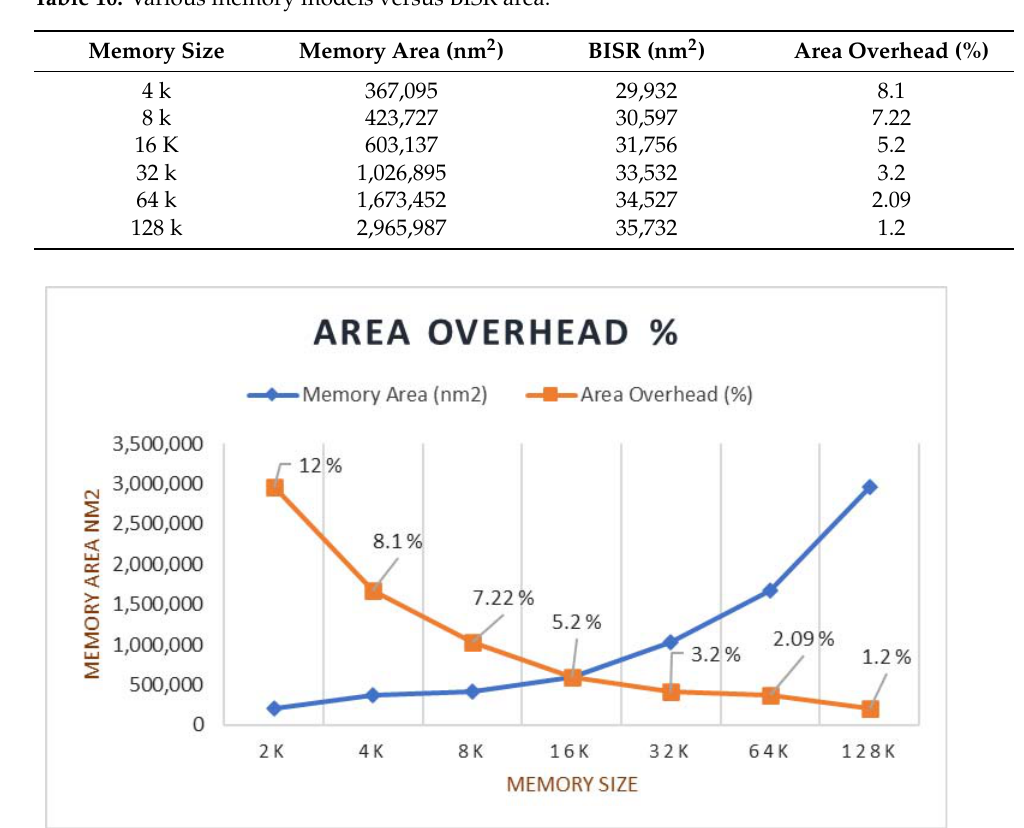
Table 9. Comparison area, timing, and power for the proposed and other BISR approaches. Design